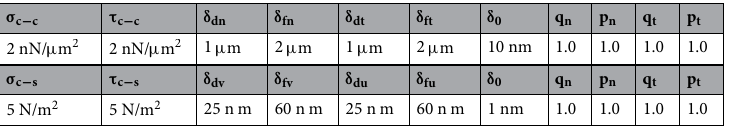
Table 1. Intercellular interaction parameters and cell-substrate interaction